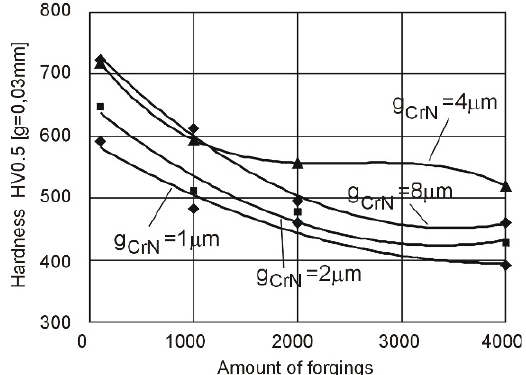
Figure 7. Change of hardness on the depth g = 0.03mm in the func- tion of the number of generated forgings for dies covered with CrN coatings with different thickness.